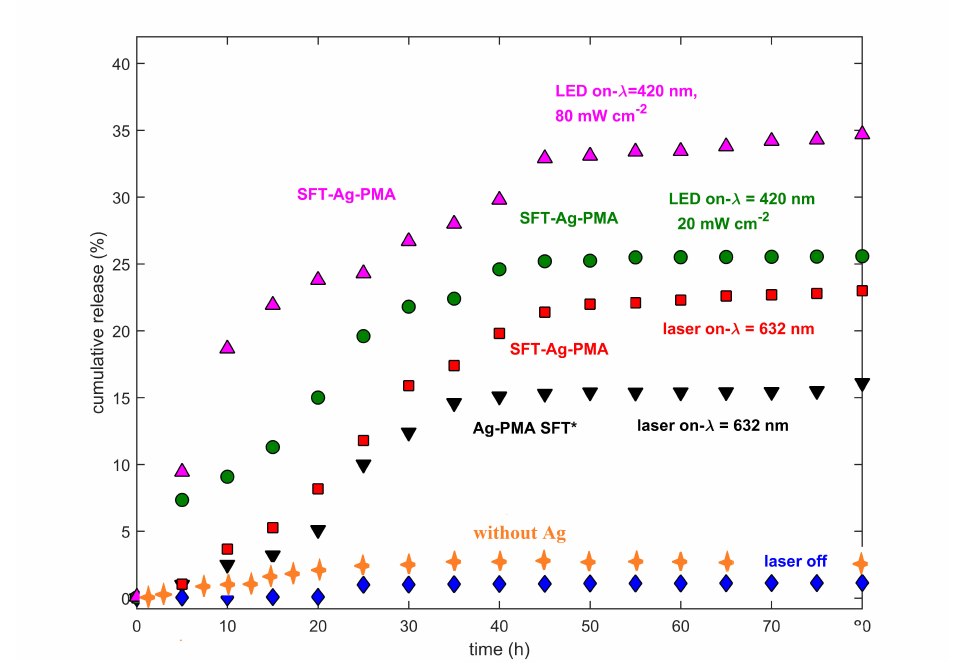
Figure 5. Drug release profiles of SFT-Ag-PMA capsules (red, green and violet symbols), collected at two different laser wavelengths (632 and 420 nm) and power levels (20 and 80 mW cm − 2 ) are reported. Drug release profiles of SFT-PMA capsules (orange crosses), the Ag-PMA SFT* colloid system (black down triangles) and SFT-Ag-PMA capsules without laser irradiation (blue diamonds) respectively, are shown. The cumulative drug released percentages as a function of time are plotted after normalization to the laser